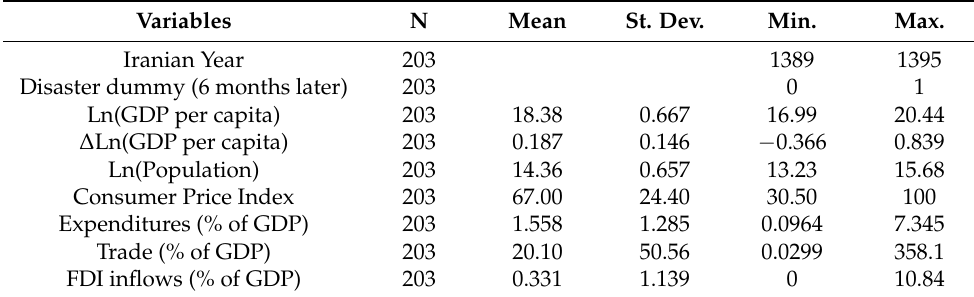
Table 1. Summary statistics of used